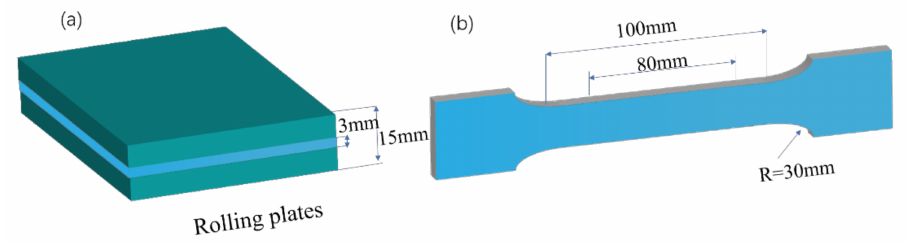
Figure 2. Specification of tensile sample: ( a ) rolling plate, ( b ) tensile specimen.